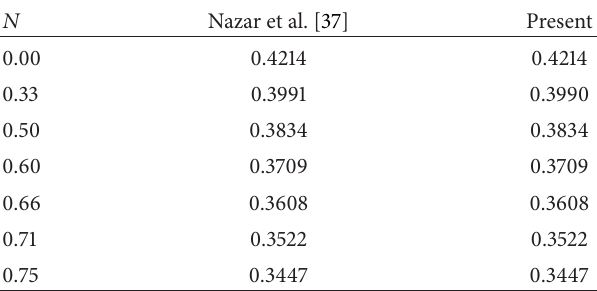
Table 2: Comparison of −𝜃 󸀠 ( 0 ) for free convection flow in a micropolar fluid obtained by Nazar et al. [37] when 𝑛 = 0 . 5, B = 0, Pr = 1, Bi → ∞ , and 𝑓 𝑤 =